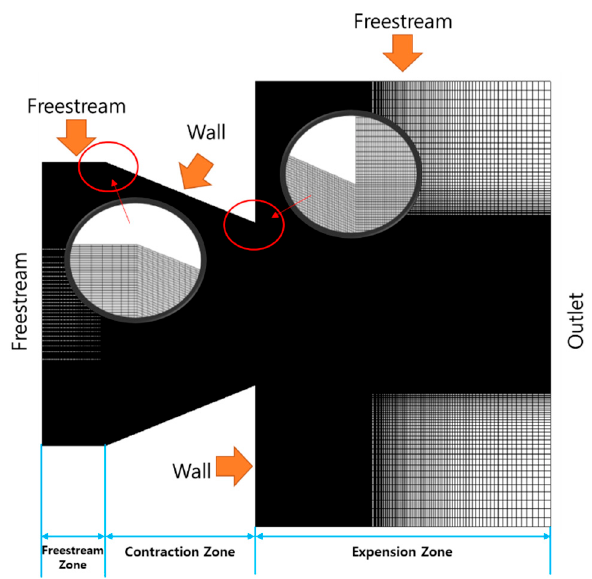
Figure 3. Computational grid for the shock reflection study. Table 2. Flow conditions for the shock reflection study.